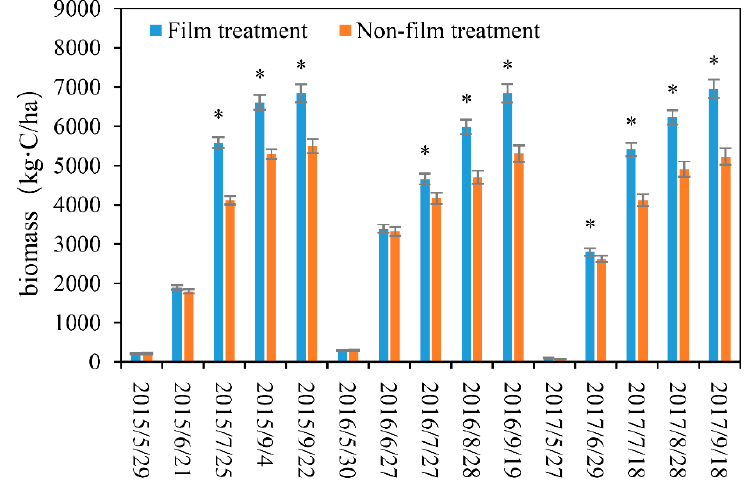
Figure 5. Biomass changes using degradable mulch film and non-filmed plots from 2015 to 2017 (* significant di ff erence at the 5% level in plant biomass between the film treatment and non-film treatment).